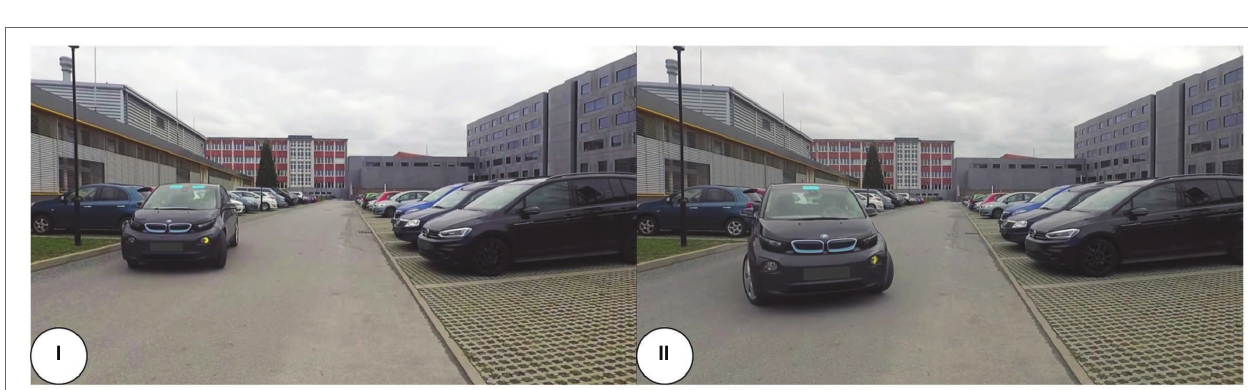
FIGURE 3 | Screenshots of the applied video material displaying the interaction vehicle initiating a left-turn maneuver into the empty parking space in front of the participants with the augmented light-based eHMI (signal: crossing mode) and the activated turn indicator. (I) The interaction vehicle initiated a left-turn maneuver (including deceleration, changes in trajectory, and steering of tires); (II) the interaction vehicle further conducted left-turn maneuver, video